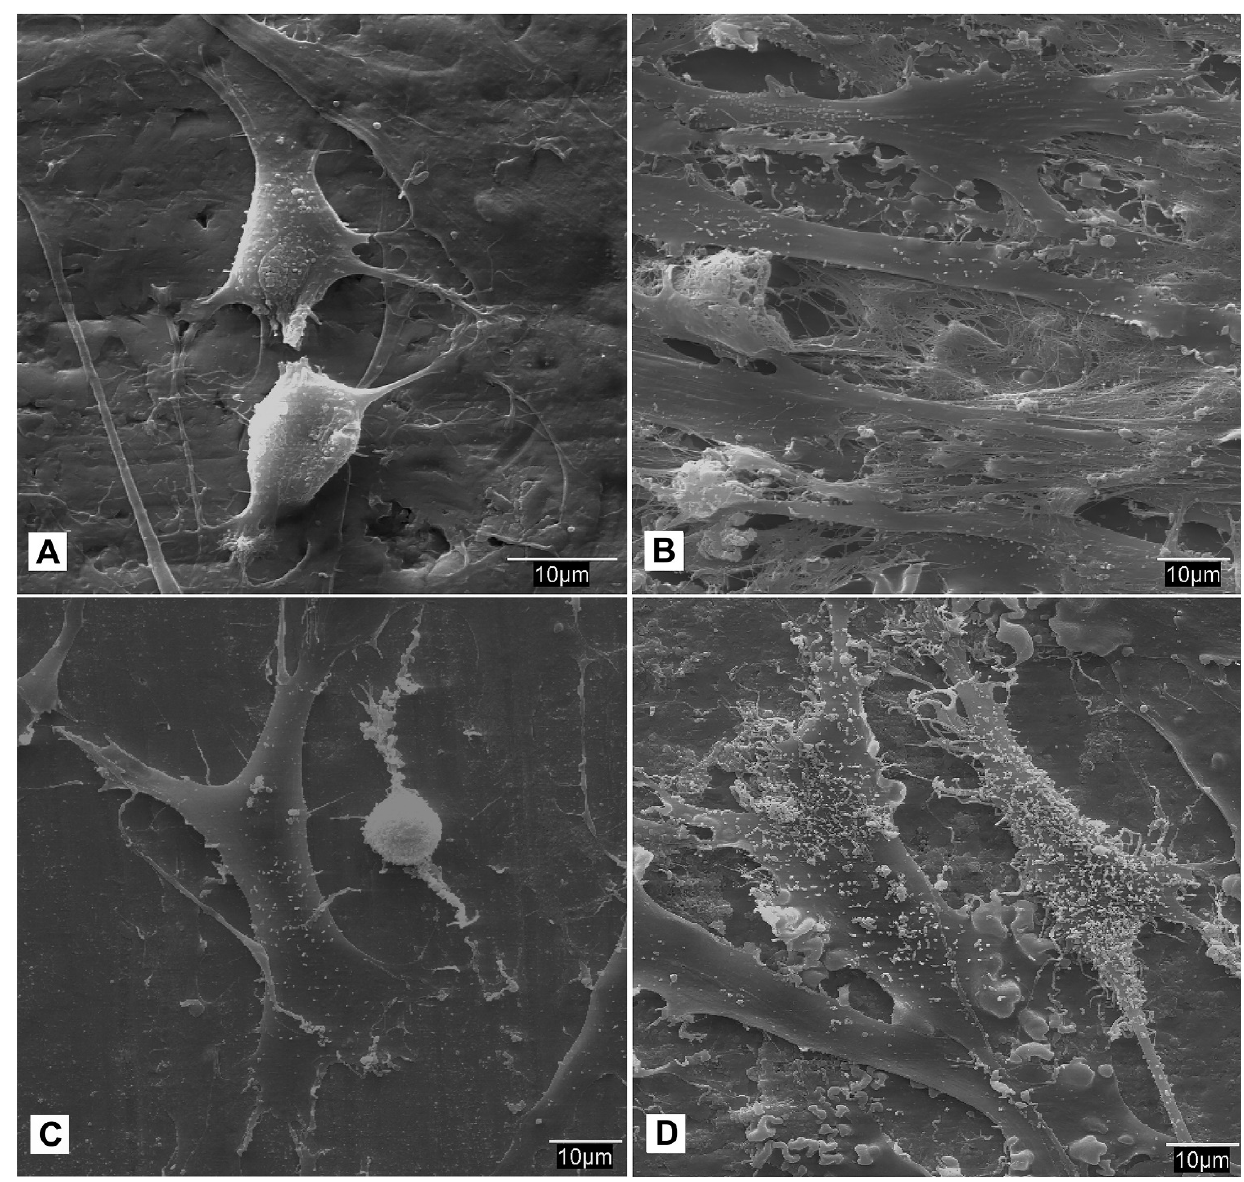
Figure 10. SEM Study of the sowing of MSCat in different incubation periods: ( A ) screws treated with BMP-2 and incubated with MSCat after 24 h at 1000×, the presence of dividing cells can be observed; ( B ) screw treated with BMP-2 after 7 days of culture with MSCat where deposits on the surface of a large quantity of secretion products can be seen at 1000×; ( C ) screw treated with BMP-2 after 14 days of culture with MSCat at 1000×; ( D ) screws treated with BMP-2 after 28 days of seeding at 1000×.